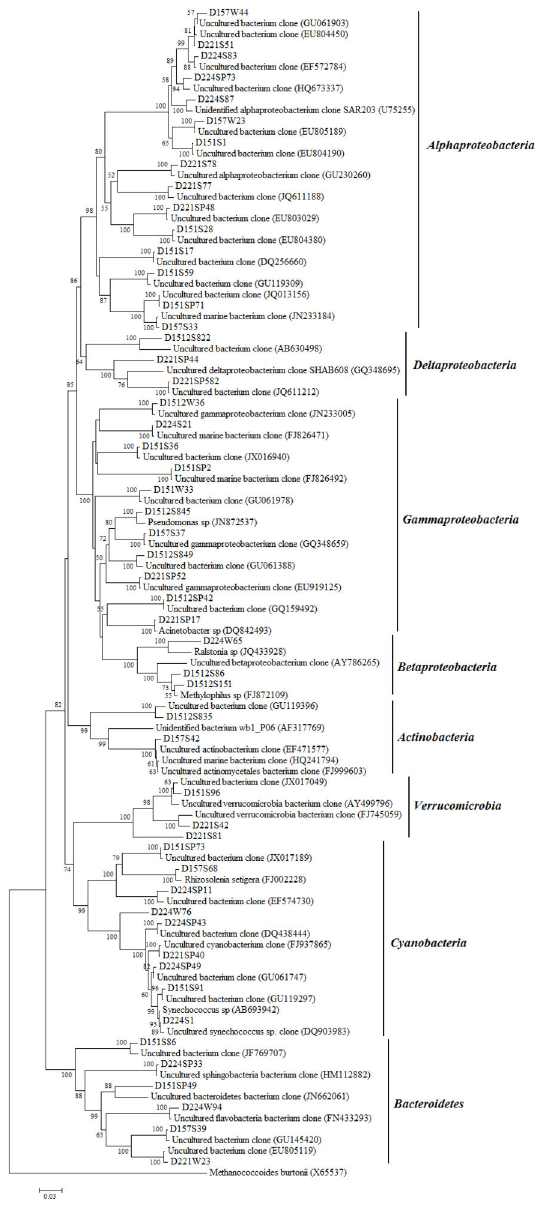
Figure 4. Phylogenetic tree based on analysis of the representative 16S rRNA gene sequences obtained from the 15 bacterial clone libraries. The tree was constructed using the neighbor-joining method in MEGA. Bootstrap analysis was conducted using 1000 replicates. Bootstrap values are shown for branches with > 50% bootstrap